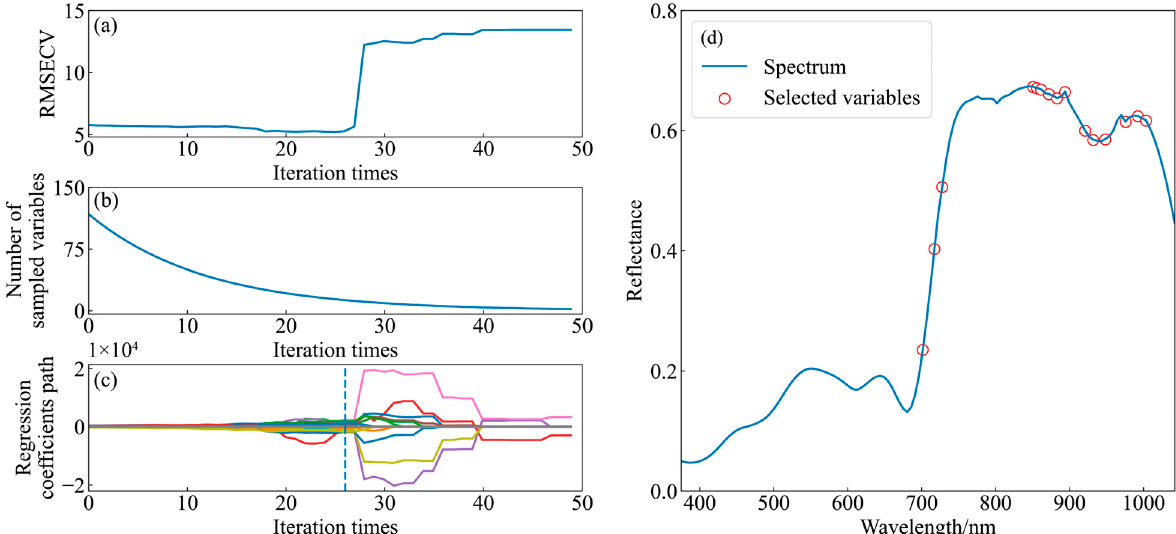
Figure 6. CARS results. ( a ) Variation in RMSECV; ( b ) variation in the number of selected features; ( c ) variation in the trend of regression coefficients; ( d ) selected wavelengths.